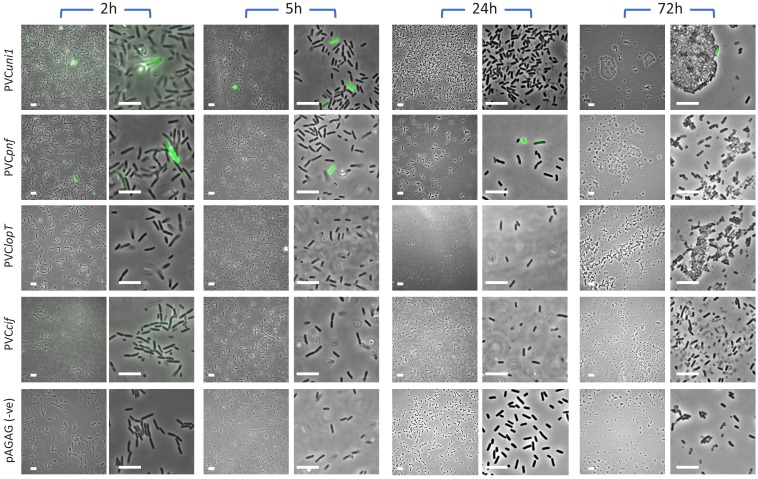
A representative selection of images for four growth time points, for P. asymbiotica.PB68.1 harbouring four different pvc-operon reporter constructs and the pAGAG negative control reporter plasmid containing no promoter. Wide field (left) and a magnified subsection (right) panels are shown for each timepoint.